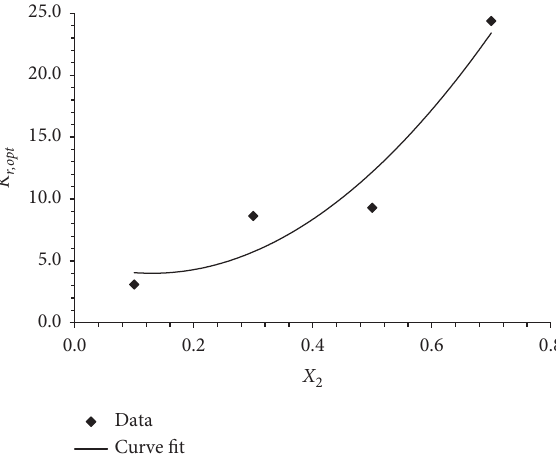
Figure 6: K r ,opt versus E for case O , χ 2 Table 4: Optimum conductivity ratio K eccentricity E .